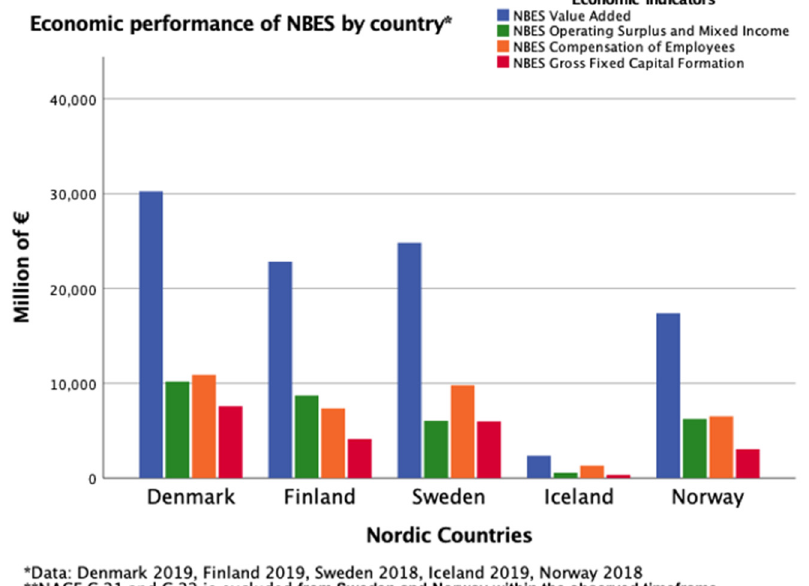
Figure 4. Economic performance of Nordic Bioeconomy Sectors (NBES) by country (Data: Eurostat 2021a, 2021b).